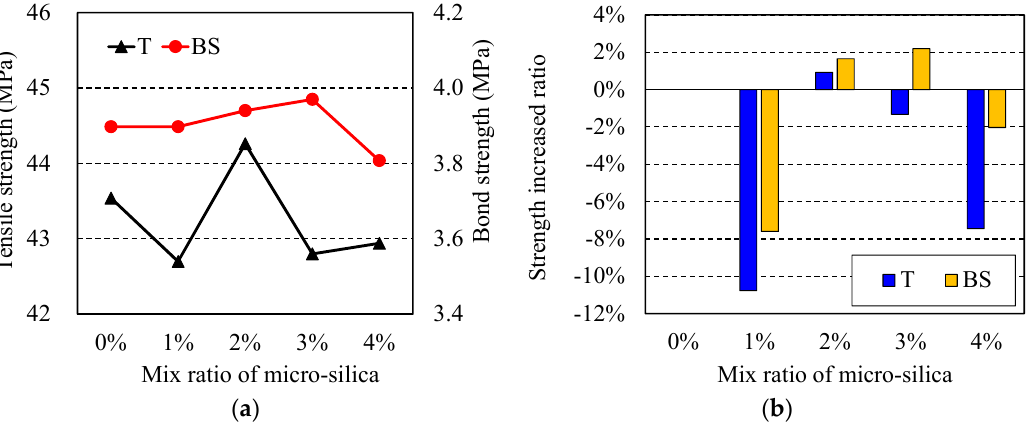
Figure 3. Test results of MSAE on mix ratios of micro-silica; ( a ) strength variation; and ( b ) ratio of strength increase.